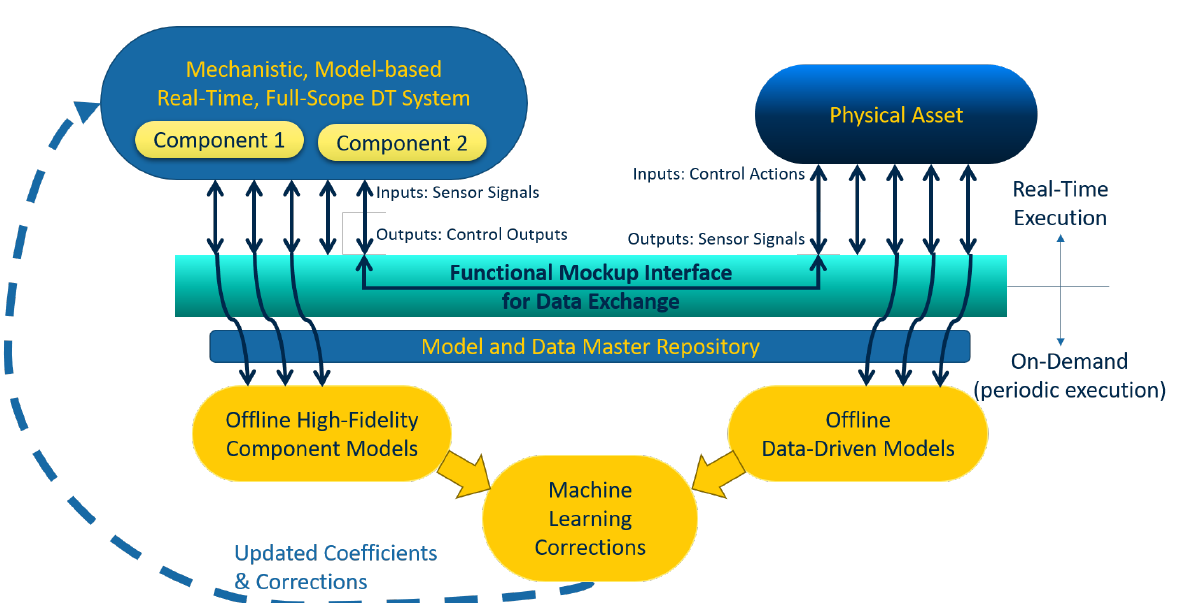
Figure 7. Paradigm for DT–Physical Asset